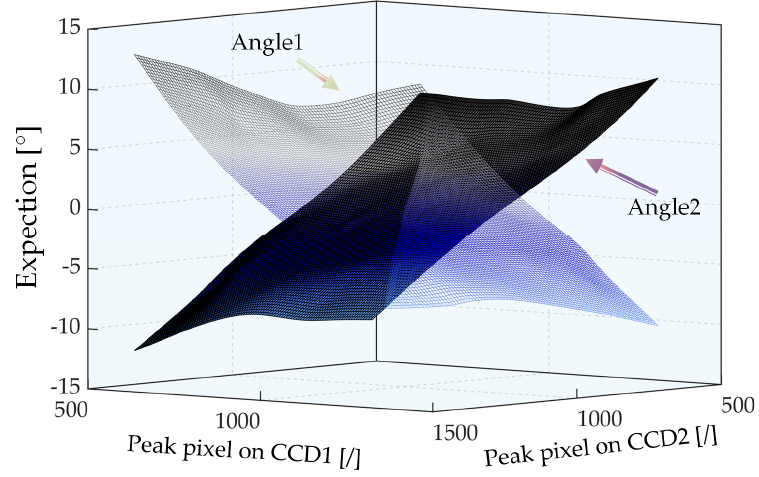
Figure 12. Fitted surface results for calibration experiments.